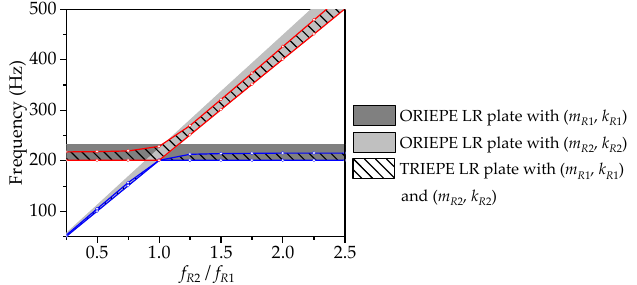
Figure 3. The effect of on the band-gap ranges in the locally resonant plate with two Figure 3. The e ff ect of f R 2 / f R 1 on the band-gap ranges in the locally resonant plate with two resonators resonators in each periodic element (TRIEPE LR plate) with and k , and two in each periodic element (TRIEPE LR plate) with ( m R 1 , k R 1 ) and ( m R 2 , k R 2 ) , and two corresponding corresponding locally resonant plates with one resonator in each periodic element (ORIEPE LR locally resonant plates with one resonator in each periodic element (ORIEPE LR plates). plates).